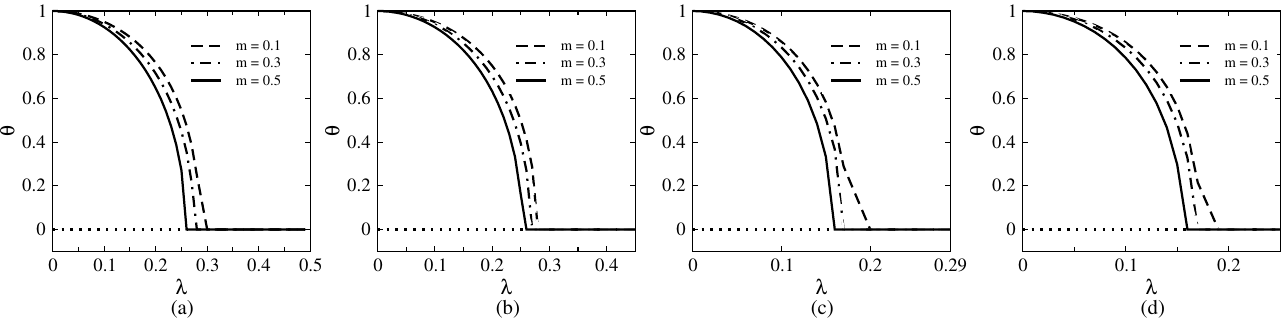
Figure 4. Bifurcation diagrams for ( a ) ω = 0.50, η = 0.1, ( b ) ω = 0.50, η = 0.2, ( c ) ω = 0.70, η = 0.1, and ( d ) ω = 0.70, η =